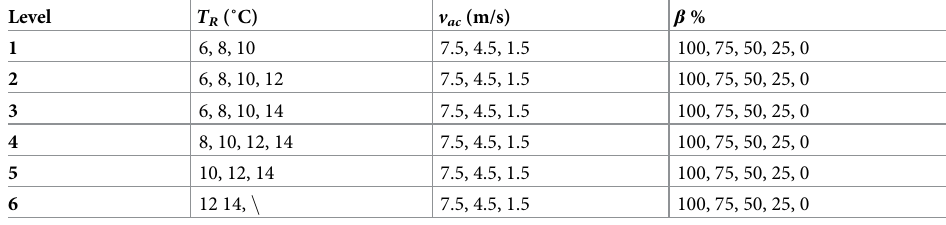
Table 2. The typical scenarios for different thermal environment levels. Level